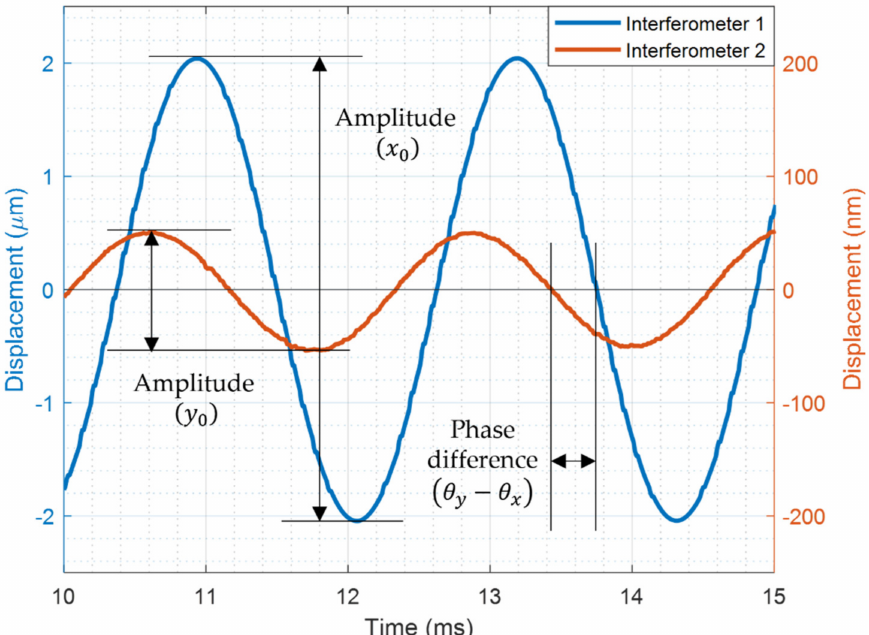
Figure 7. The displacements induced by the vibrations of two fundamental modes of a hemispherical resonator derived by a single actuator. The system was rotated by a constant rate of Ω z = − 4.19 ◦ /s. A phase difference of 61.8 ◦ between two modes was measured.